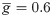
Relative root mean squared errors (RRMSE) (%) of CDS and strip transect estimators estimators (strip widths ranging from 0 to 1) of N, for 4 detection functions, with E[n] = 400, P = 0.1 and g¯=0.6.